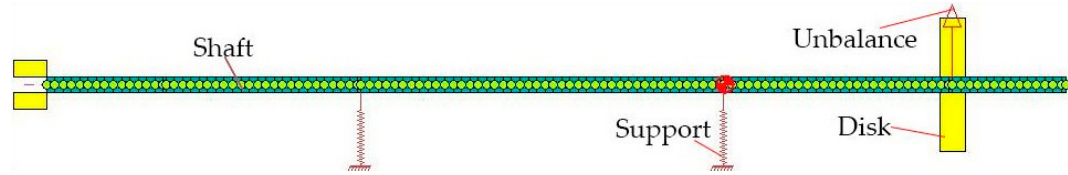
Figure 5. Rotor dynamics model.